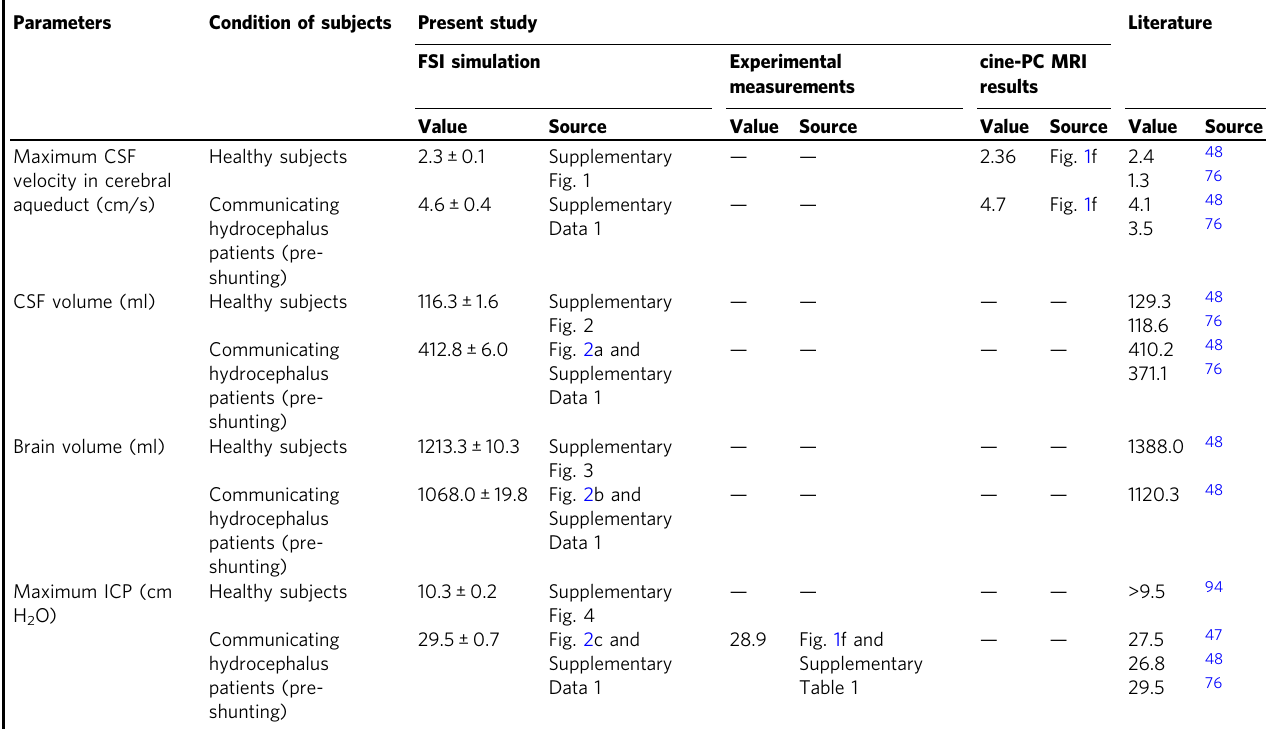
Table 1 Comparison of the results of the present study with the results of cine-PC MRI, experimental ICP, and previous studies. CSF volume means the volumes of SAS and ventricular